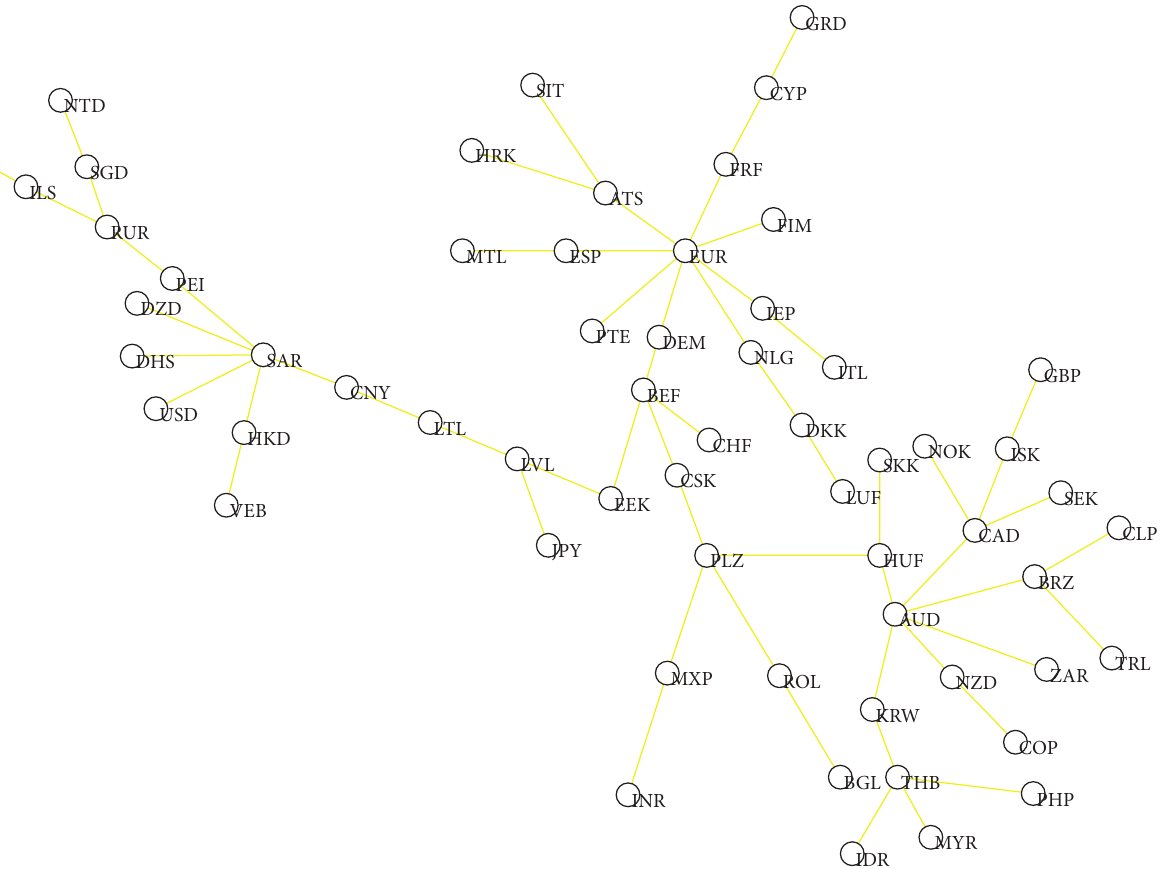
Figure 5: MST of 61 currencies during February 1994–November 2014, as an overall